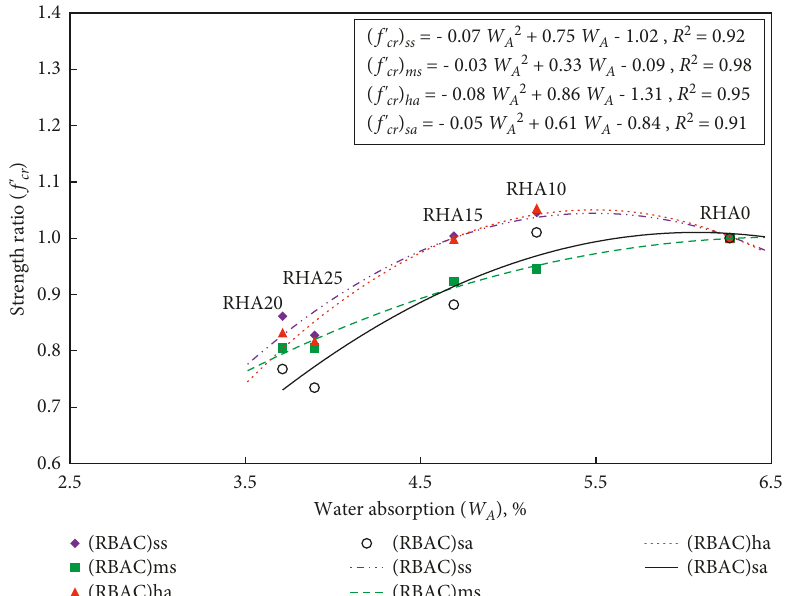
Figure 14: Relationship between water absorption and strength ratio of RBAC immersed in chemical water for 90 days ((RBAC)ss � RBAC immersed in sodium sulfate solution, (RBAC)ms � RBAC immersed in magnesium sulfate solution, (RBAC)ha � RBAC immersed in hydrochloric acid solution, and (RBAC)sa � RBAC immersed in sulfuric acid